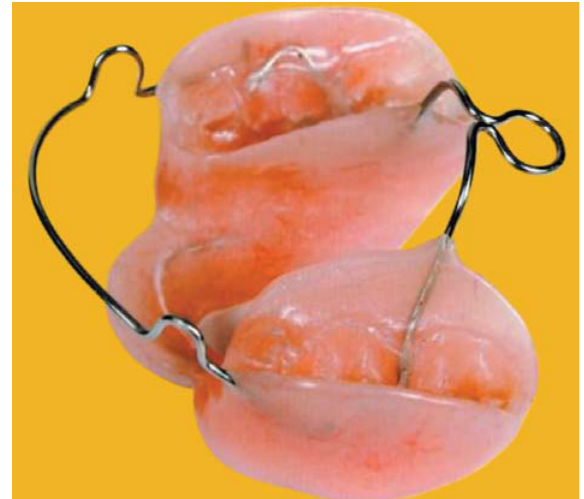
Figure 2- R-appliance